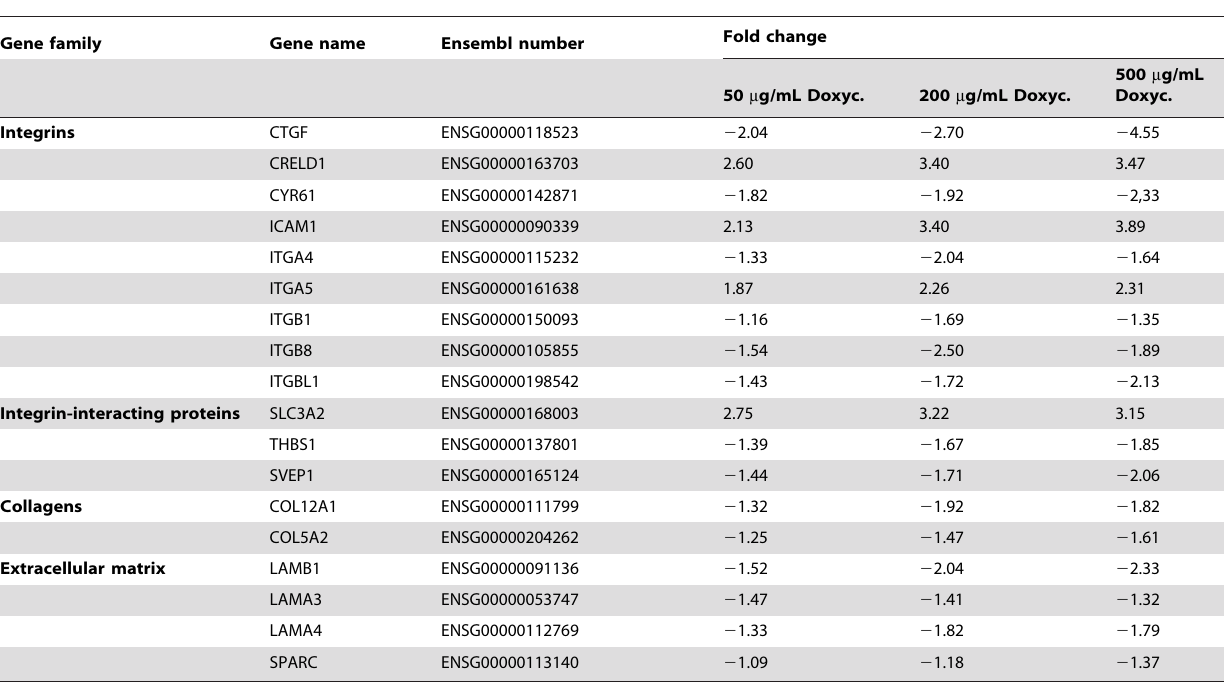
Table 2. Ultrasequencing values for integrins and extracellular matrix-related genes.